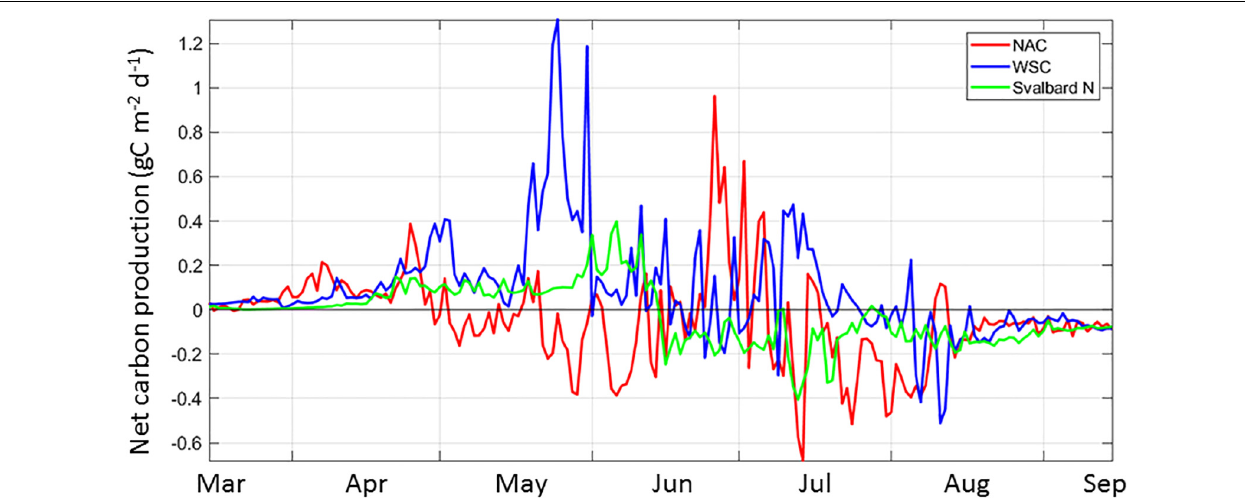
FIGURE 8 | The spatial and temporal variability of Net Carbon Production (NCP) from March to September for three regions along the Atlantic Water Inflow: the Norwegian Atlantic Current (NAC, red), the West Spitsbergen Current, (WSC, blue) and North of Svalbard (Svalbard N or NSv, green) for the year 2012. Representative locations for these three regions are indicated in Figure 1b